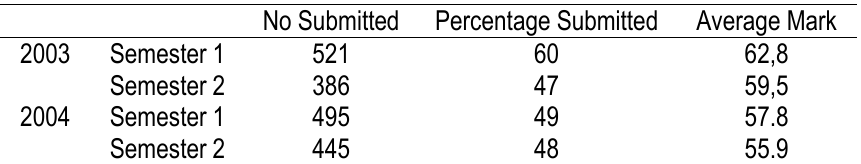
Table 1.1a. Number of assignments submitted by MNX202-J students